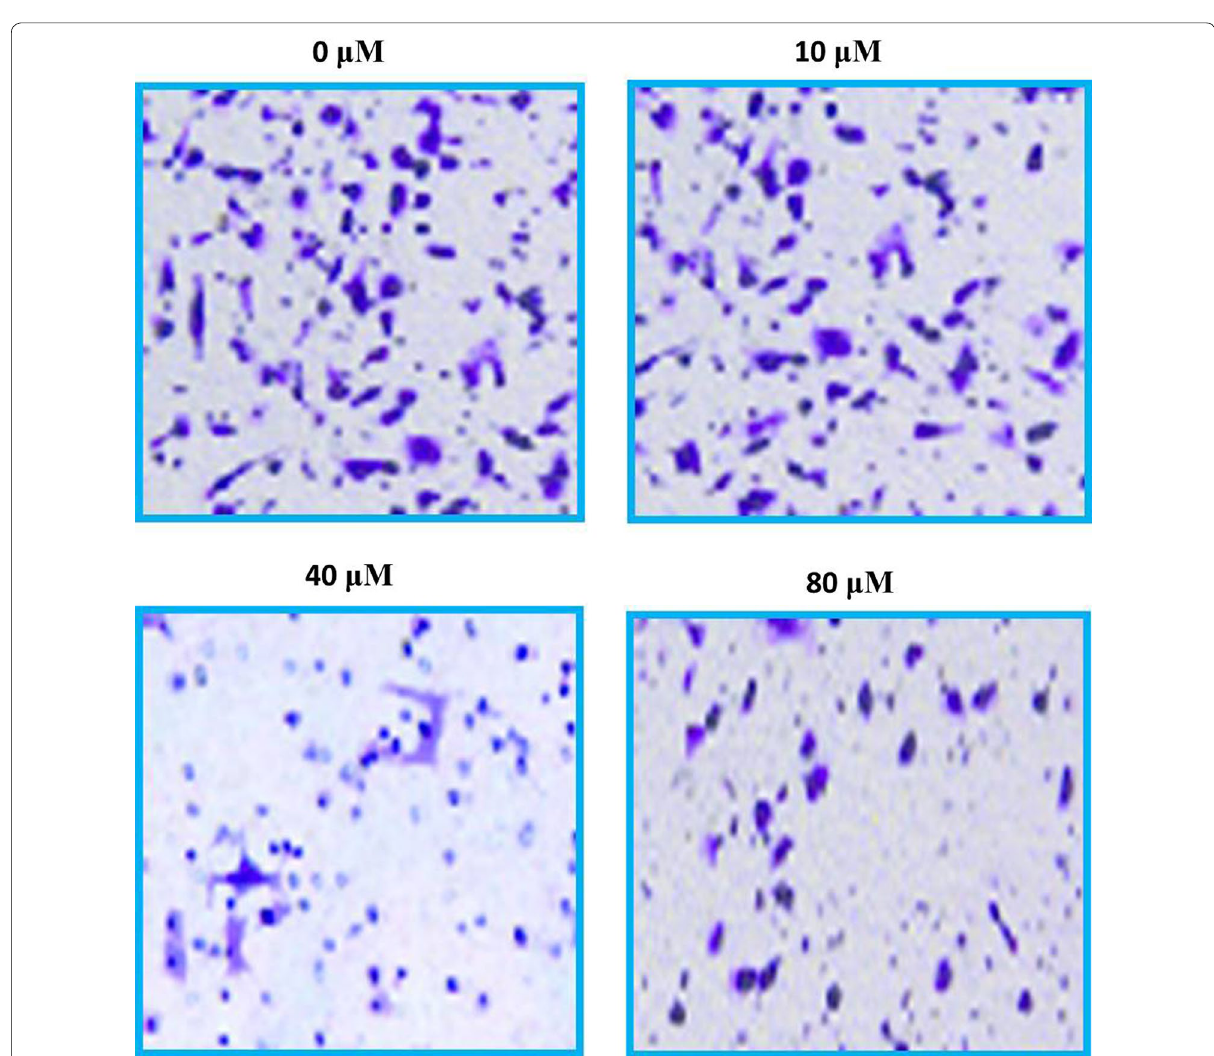
Fig. 9 Images presenting the cellular invasion of SHSY-5Y cells after being exposed to maslinic acid at indicated doses. For maximum precision three individual experiments were